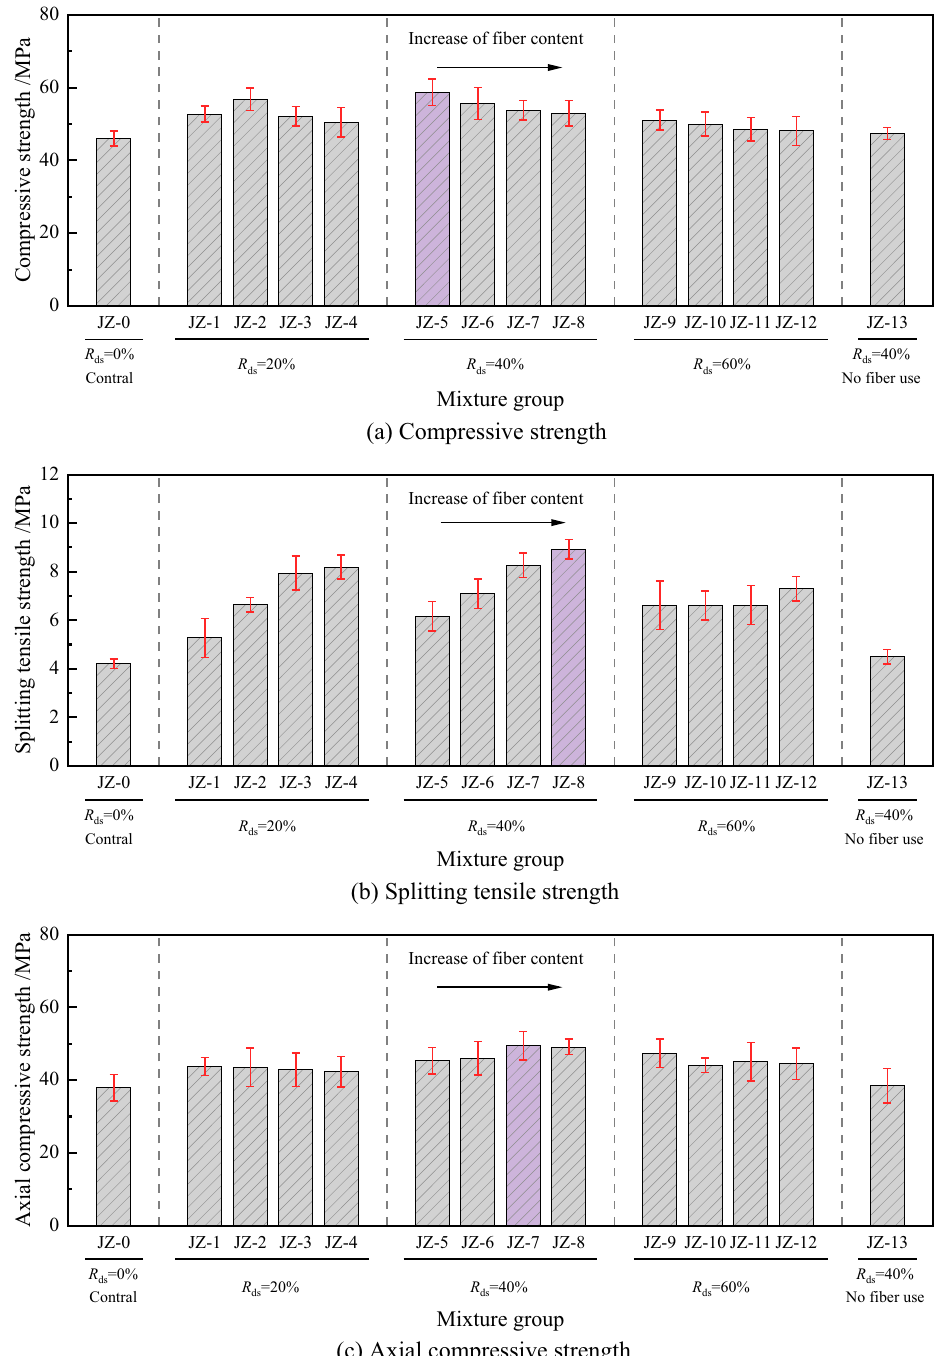
Figure 4. Mechanical properties of concrete with different R ds and V sf